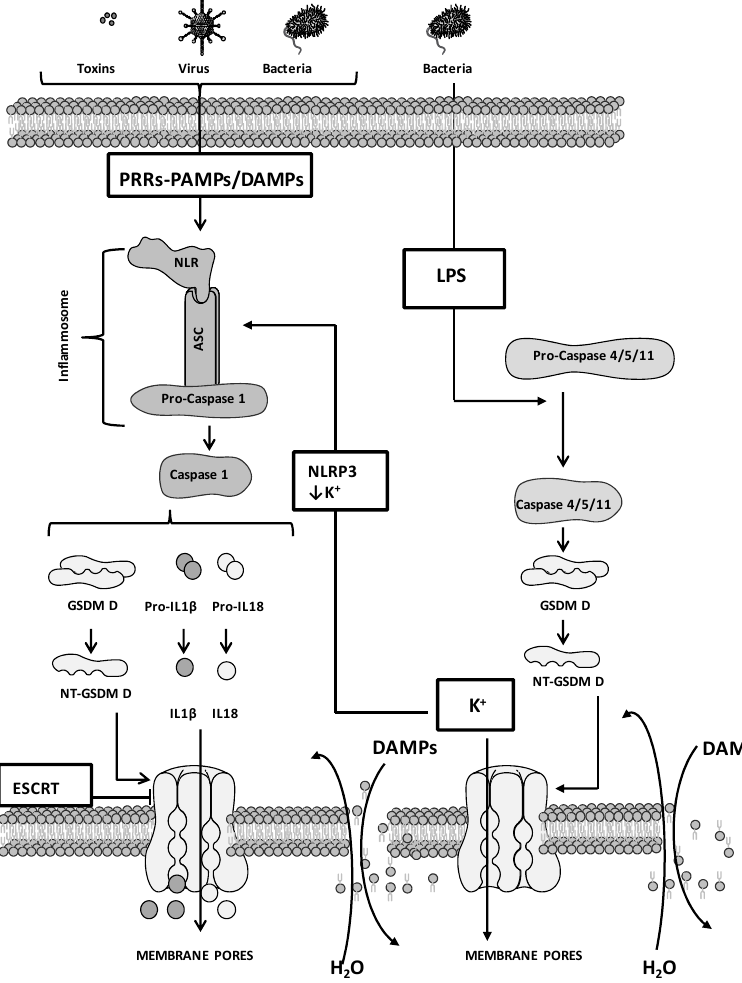
Figure 1. Caspase ‐ dependent mechanisms of pyroptosis. The figure is prepared using tools from Figure 1. Caspase-dependent mechanisms of pyroptosis. The figure is prepared using tools from Servier Medical Art (http://www.servier.fr/servier ‐ medical ‐ art (accessed on 1 November 2022). Servier Medical Art (http://www.servier.fr/servier-medical-art (accessed on 1 November Caspase 4/5/11 ‐ mediated non ‐ canonical pathway. The non ‐ canonical pathway in ‐ volves caspase 11 in mouse and its human homologs, caspase 4 and 5 (Figure 1). The CARD of caspase 4/5/11 recognizes LPS and induces oligomerization and proteolytic ‐ me ‐ diated caspase self ‐ activation. Activated caspase leads to the release of NT ‐ GSDM D, the formation of membrane pores, and PYR [43,44,65,66]. Caspase 4/5/11 are unable to directly stimulate the activation of pro ‐ IL18 and pro ‐ IL1 β , and the inflammasome governing this non ‐ canonical pathway is the NOD ‐ like receptor family pyrin domain containing 3 (NLRP3) inflammasome. The release of IL1 β and IL18 occurs following the activation of NLRP3 and is mediated by potassium efflux, which is stimulated by the formation of caspase 4/5/11 ‐ mediated NT ‐ GSDM D pores [67–69]. An alternative non ‐ canonical path ‐ way involves the caspase 11 ‐ mediated cleavage of the pannexin ‐ 1 (PANX1) channel. This process stimulates the release of ATP in the extracellular compartment, which activates the P2X ligand ‐ gated ion channel (P2 × 7) receptors, in turn leading to PYR [70]. Caspase 3/8 ‐ mediated pathway. Although recognized as crucial factors for the induc ‐ tion of necroptosis and apoptosis, caspase 3 and 8 are implicated in PYR as well (Figure 2 [71]). Following caspase 3 activation, GSDM E is cleaved (at the Asp270 residue) and re ‐ leases NT ‐ GSDM E aggregates to form membrane pores, leading to the disruption of plasma membrane integrity and in turn to PYR. Of note, PYR is counteracted by caspase 3 cleavage of GSDM E at a different cleavage site (Asp87 instead of Asp270), allowing the production of shorter NT ‐ GSDM E peptides unable to form functional membrane pores